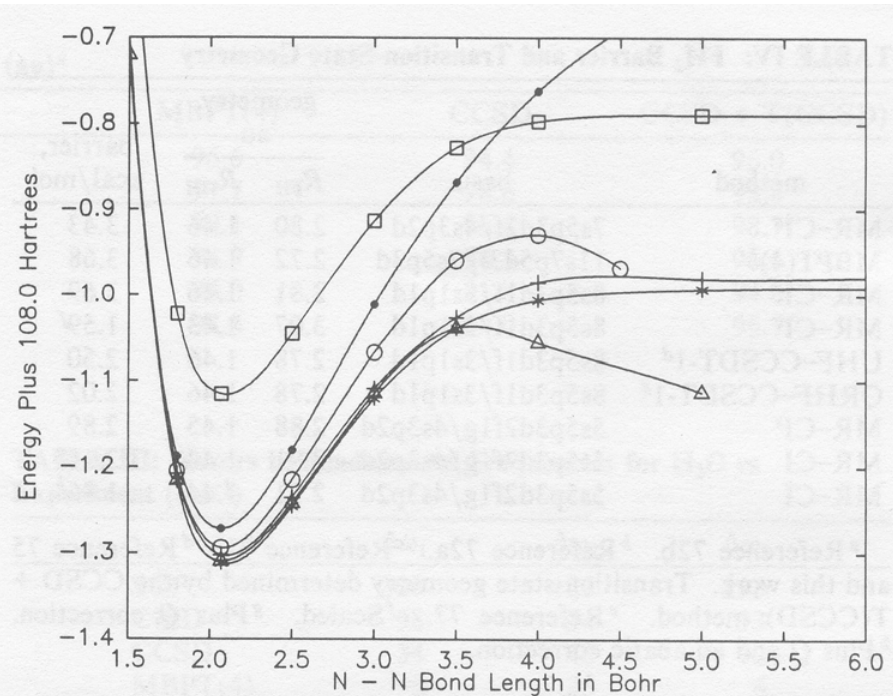
Figure 3: RHF-based CISD, CCSD, CCSDT-1, MCSCF, MR-CISD, and MR-LCCM potential curves for N 2 (absolute scale). The various curves are identified as follows: ( • ) CISD, ( ◦ ) CCSD, ( (cid:5) ) CCSDT-1, ( (cid:1) ) MCSCF, (+) MR-CISD, and (*)